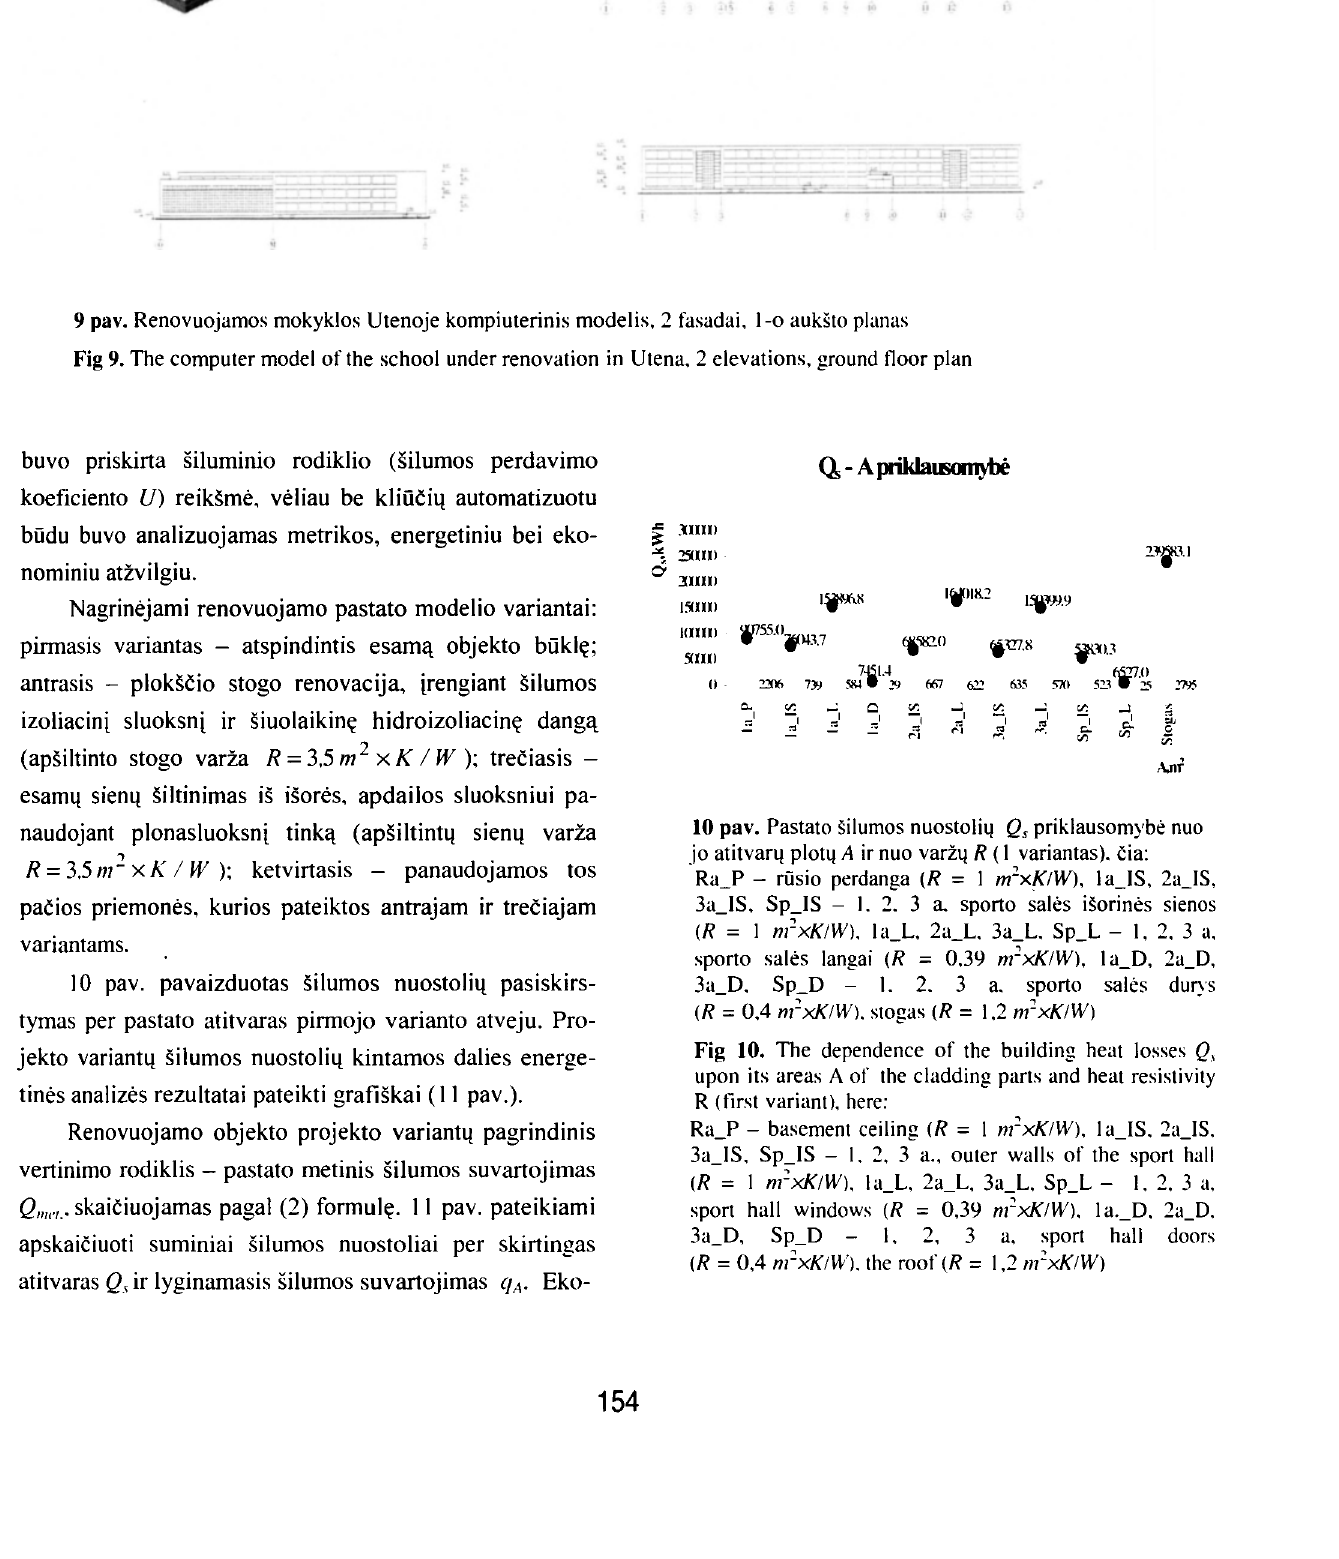
Fig 9. The computer model of the school under renovation in Utena. 2 elevations, ground floor plan